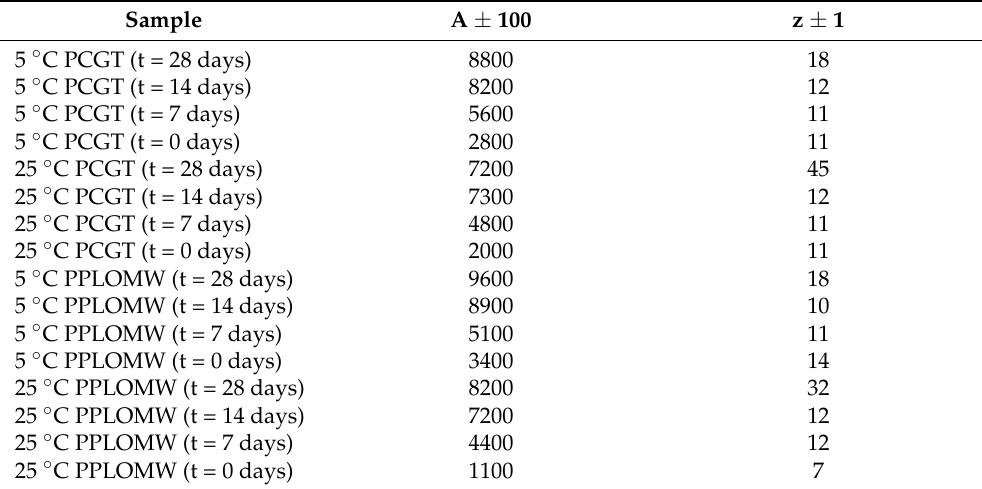
Table 7. Frequency sweep test for PPLOMW food matrices and PCGT over time.